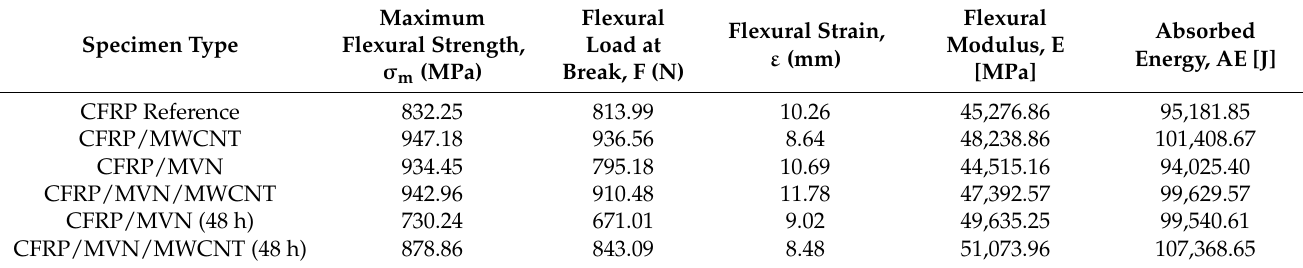
Figure 15. Flexural test results for the ( a ) CFRP reference specimens and ( b ) MWCNT specimens, ( c ) MVN specimens, and ( d ) MVN/MWCNT specimens after first and second testing. Table 6. Average results for all three-point bending CFRP composite